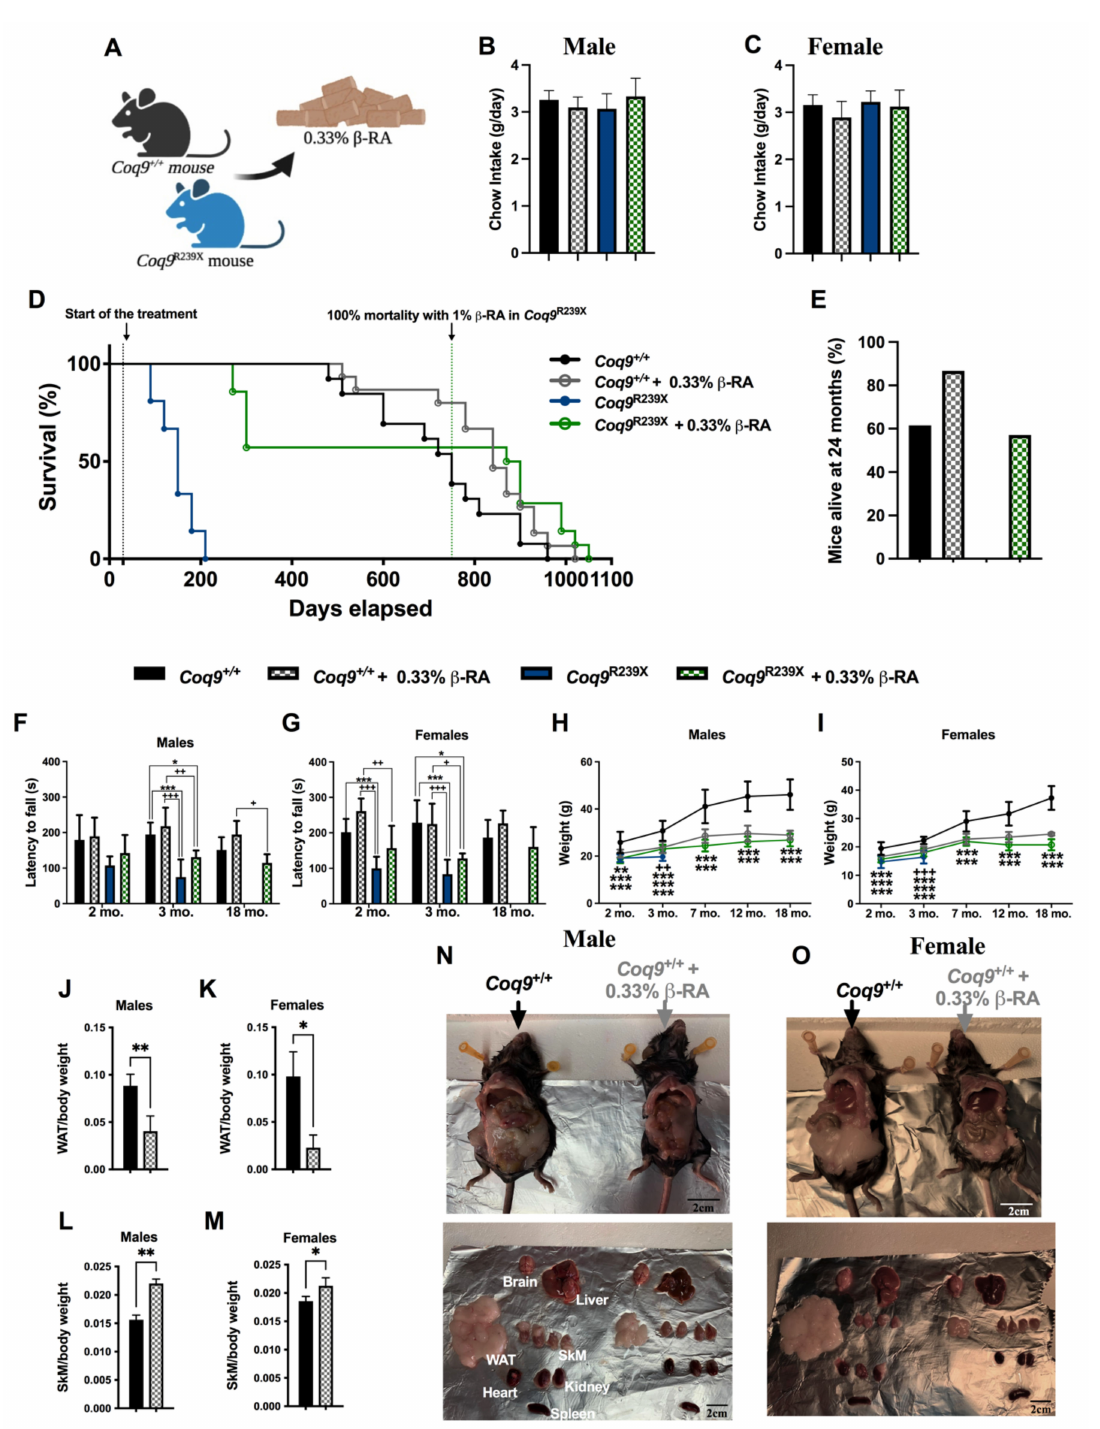
Figure 1. Survival and phenotypic characterization of Coq9 +/+ and Coq9 R239X mice during the supplementation with 0.33% β -RA. ( A ) Schematic figure of the β -RA treatment in Coq9 +/+ and Coq9 R239X mice. ( B , C ) Daily food intake in male and female Coq9 +/+ and Coq9 R239X mice. ( D ) Survival curve of the Coq9 +/+ mice, Coq9 +/+ mice given 0.33% β -RA supplementation, Coq9 R239X mice, and Coq9 R239X mice given 0.33% β -RA supplementation. The treatments started at 1 month of age (log-rank (Mantel–Cox) test or Gehan–Breslow–Wilcoxon test; Coq9 +/+ mice, n = 13; Coq9 +/+ mice under 0.33% β -RA supplementation, n = 15; Coq9 R239X mice, n = 21; Coq9 R239X mice under 0.33% β -RA supplementation, n = 14). ( E ) Percentage of mice alive